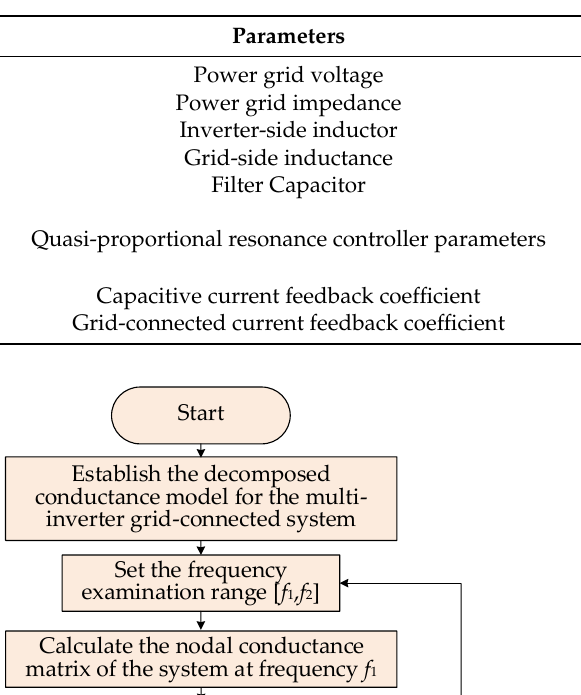
Table 1. The parameters of the grid-connected inverter.